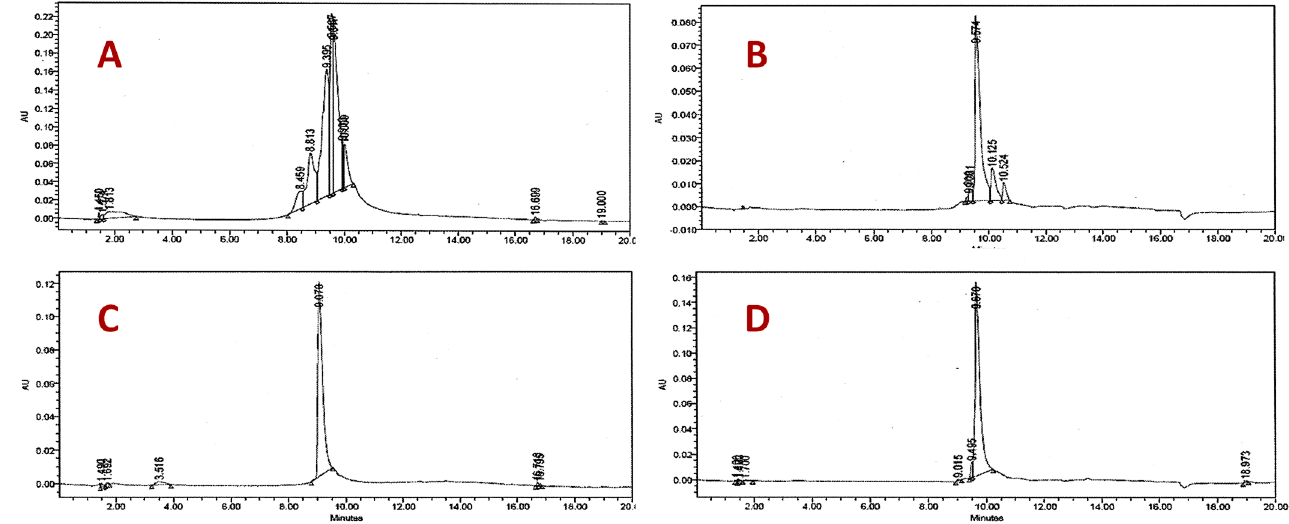
Figure 1. HPLC chromatograms of: ( A ) ethyl acetate extract; ( B ) compound 1 (t R = 9.574 min); ( C ) compound 2 (t R = 9.078 min); and ( D ) compound 3 (t R = 9.670 min).